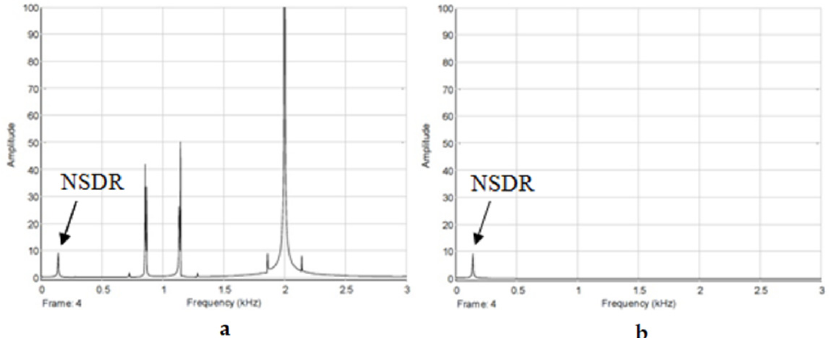
Figure 10. Frequency analysis of the position signal in dq when NSDR is introduced ( a ) before filtering interfering signals ( b ) after filtering.